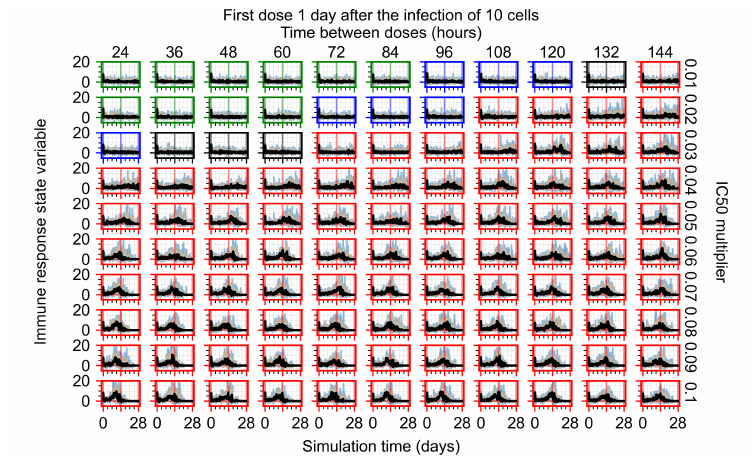
Figure A56. Immune response state variable number. Positive values correspond to an inflammatory state, and negative to an anti-inflammatory state.